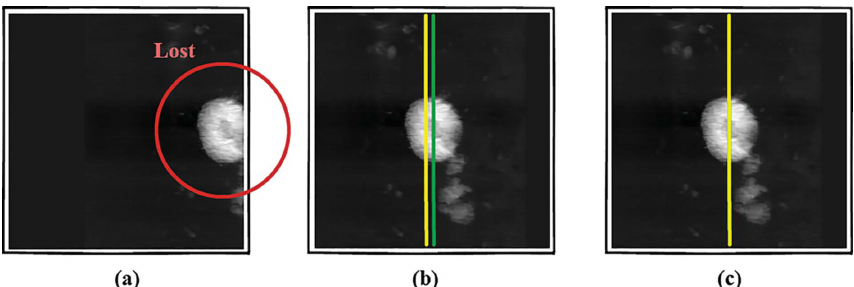
Figure 8 Algorithms validation using a XANES